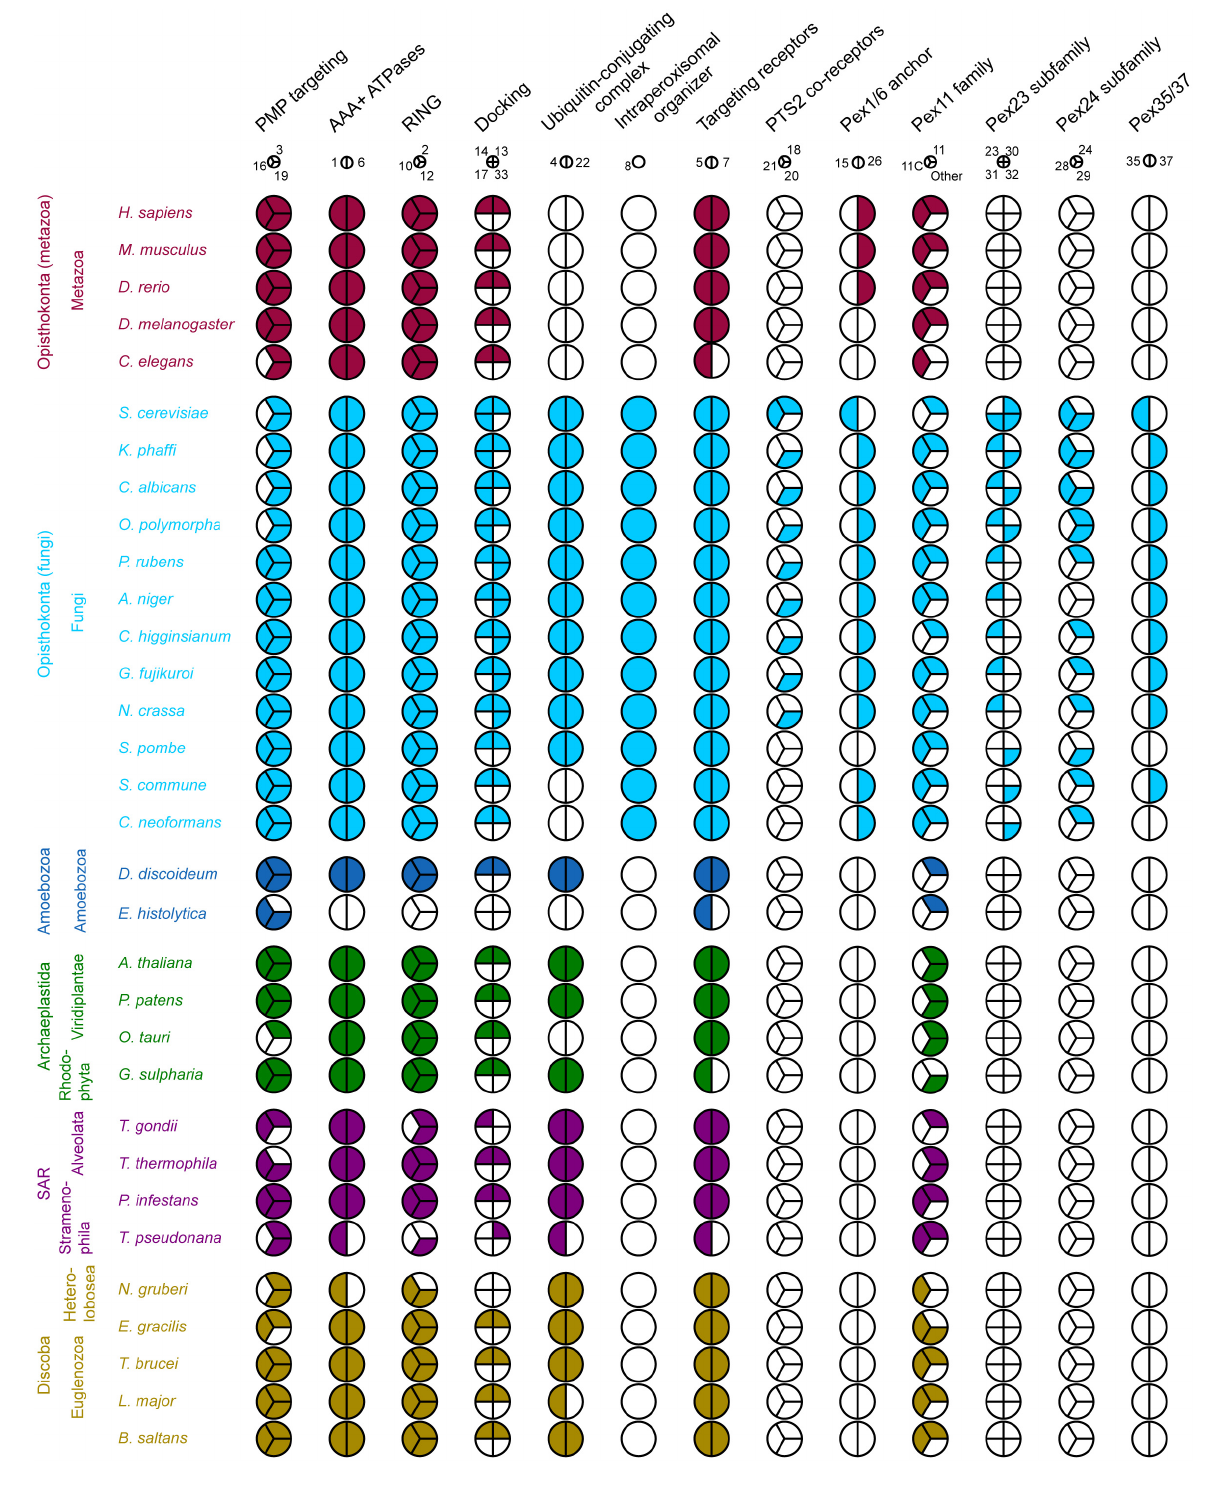
Frontiers in Cell and Developmental Biology |